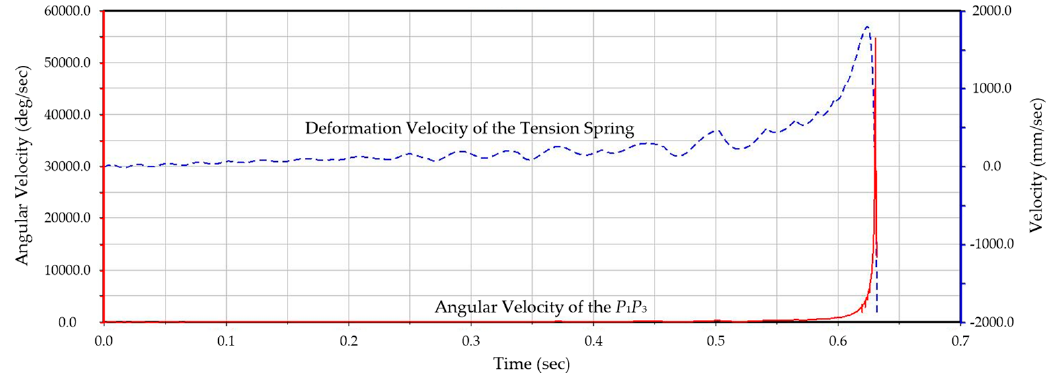
Figure 10. Simulation results of the HR-A. The deformation velocity of the tension spring and the angular velocity of the crank–gear–bar P 1 P 3 .